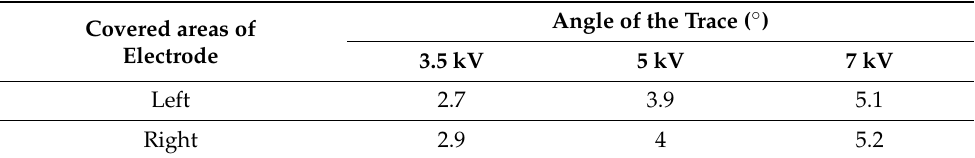
Table 2. Angle of the trace on different voltages and covered areas.